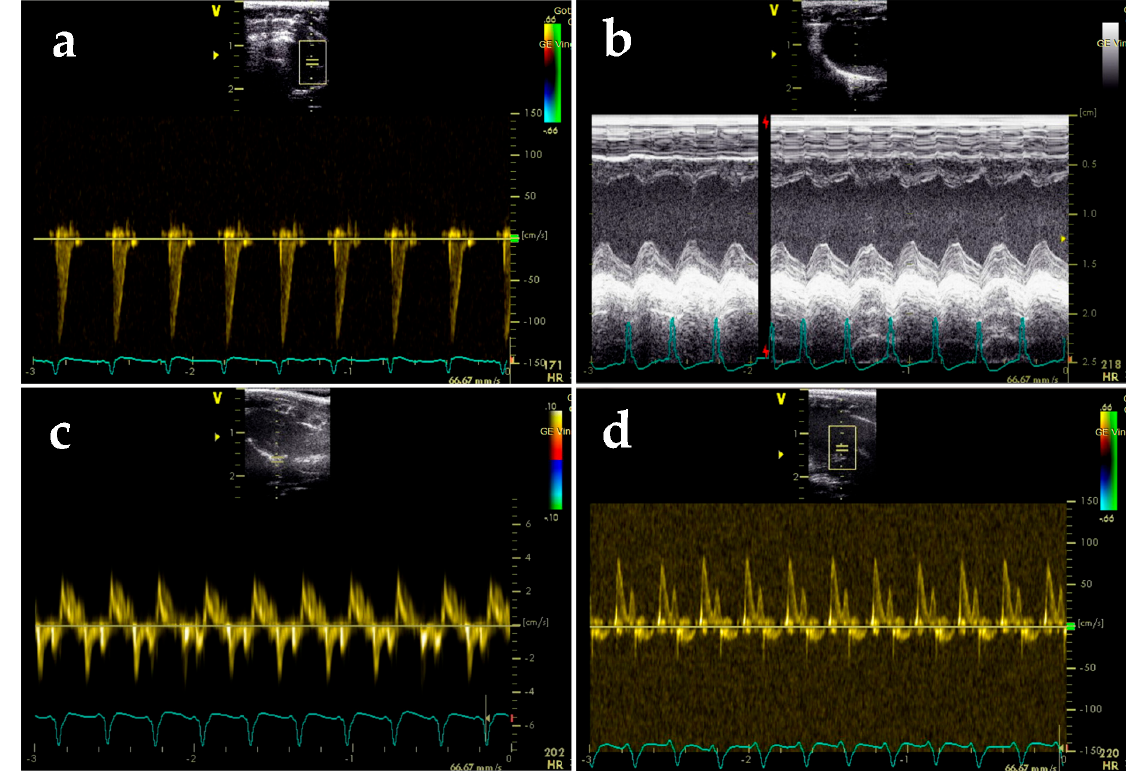
Figure 7. Representative images of echocardiographic experiments. ( a ) Left-ventricle outflow tract (LVOT), visualized by Doppler echocardiography; ( b ) parasternal long axis, M-mode image of left ventricle; ( c ) 3-chamber view, mitral annular velocities, tissue Doppler mode; ( d ) mitral inflow velocities, visualized by Doppler echocardiography.